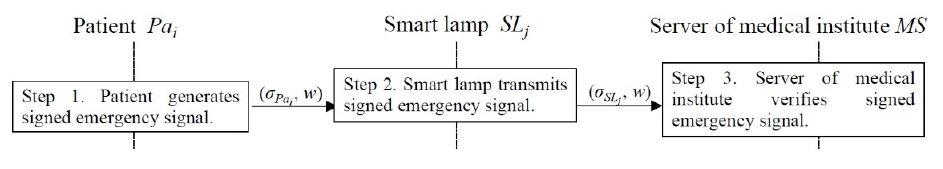
Figure 5. Emergency signal sending phase.